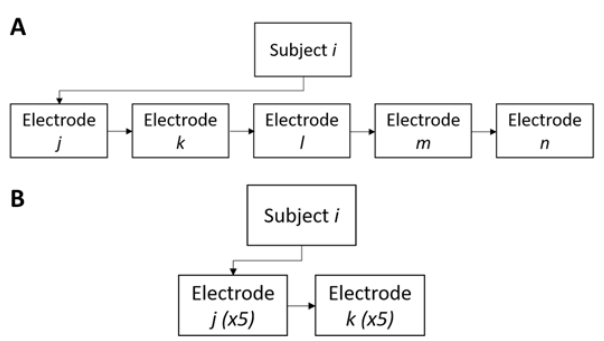
Figure 4. Flow charts of inter-subject ( A ) and intra-subject ( B ) analyses.